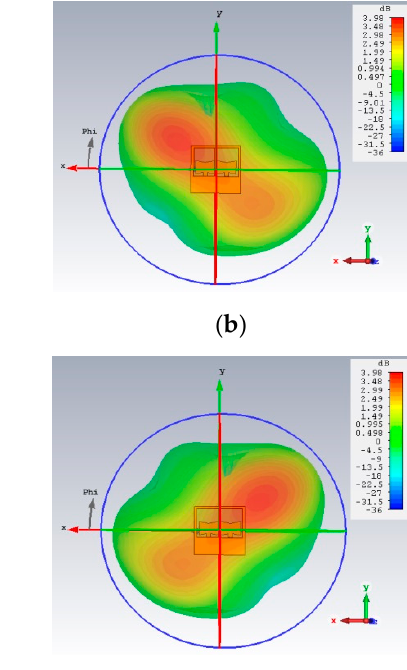
Figure 13. 3D Realized Gain patterns in the middle of the low frequency band (937 MHz): ( a ) and ( b ) in front of and back of the antenna plane (port p1 is fed), ( c ) and ( d ) respective results when port p2 is fed.